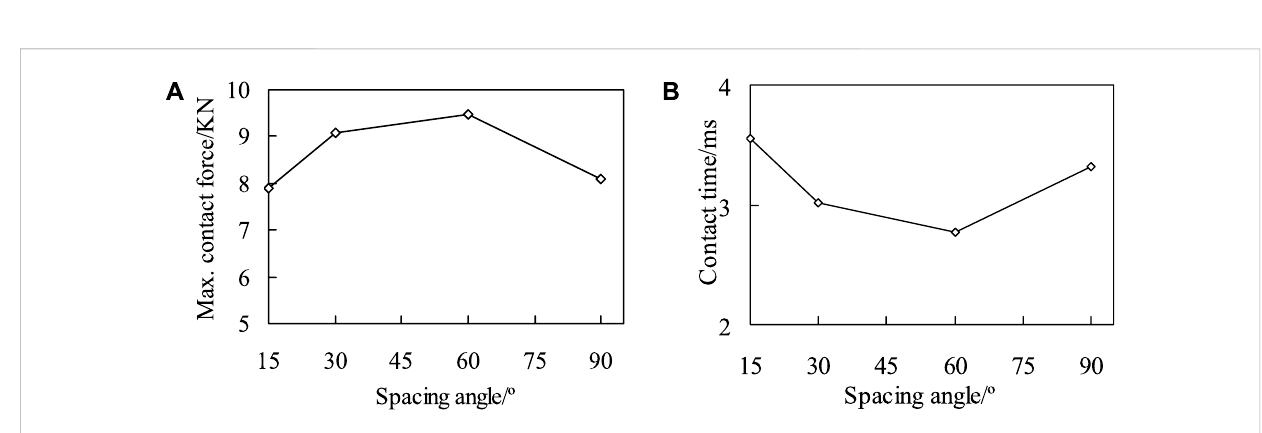
FIGURE 6 The maximum contact force (A) and contact time (B) of four different models when the impact energy is 20